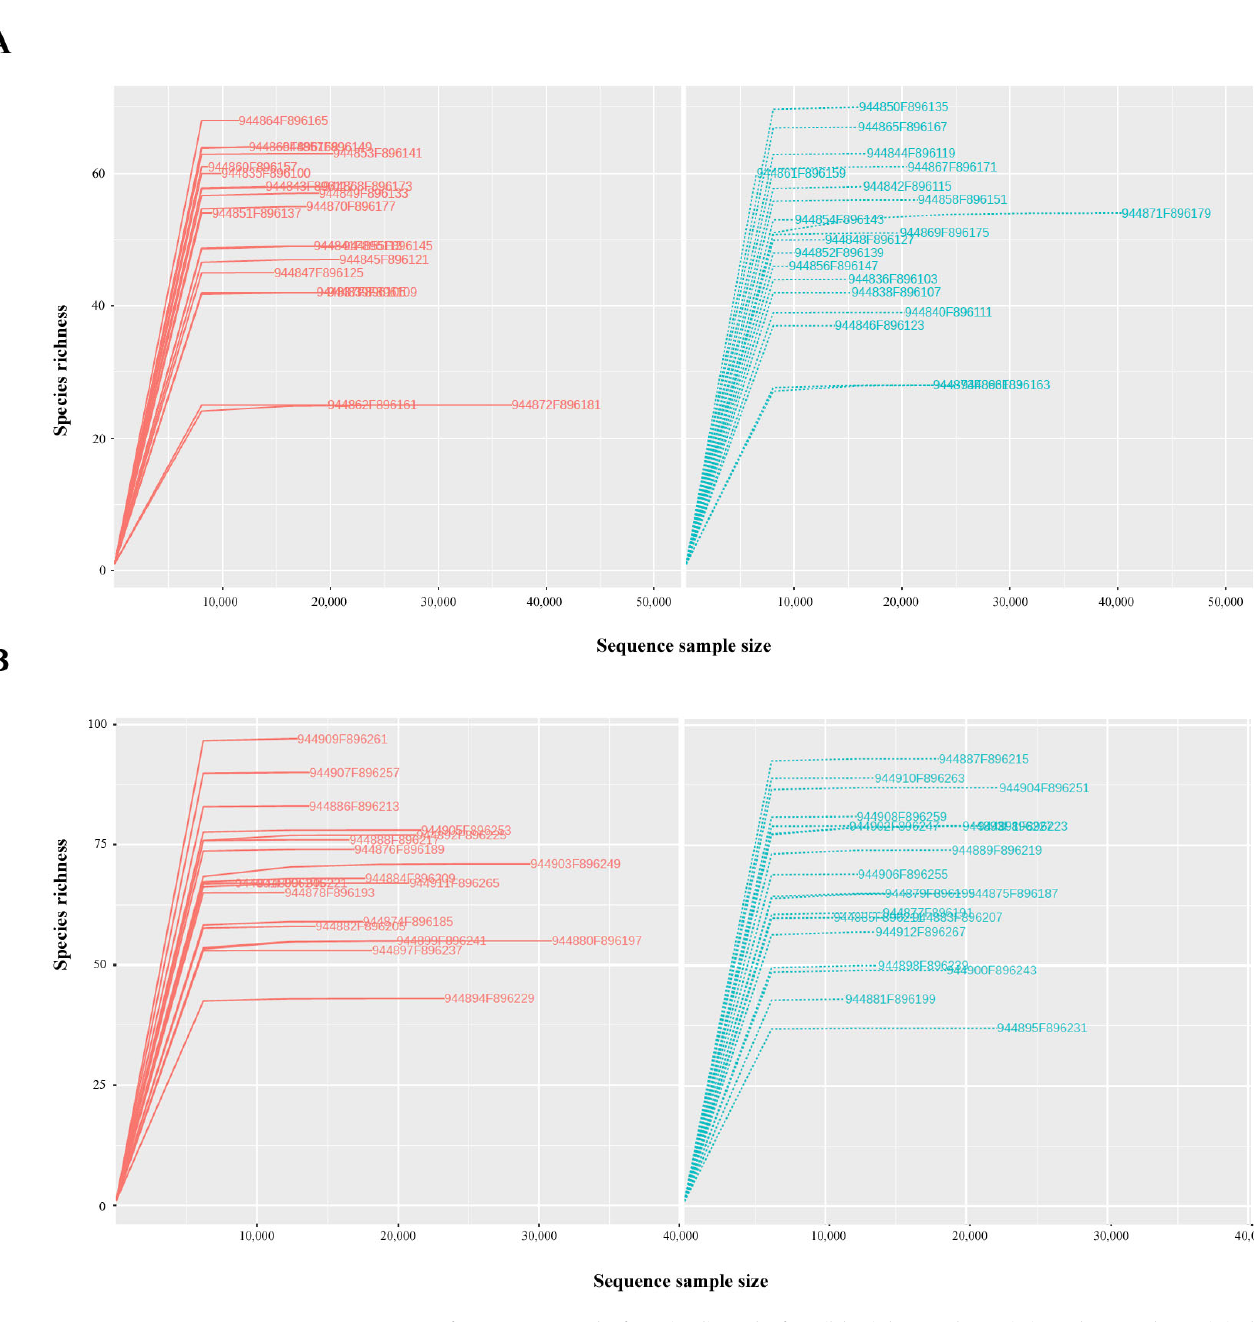
Figure 1. Rarefaction curves before (red) and after (blue) low-calorie ( A ) and two-phase ( B ) diet. Every curve corresponds to a single sample.